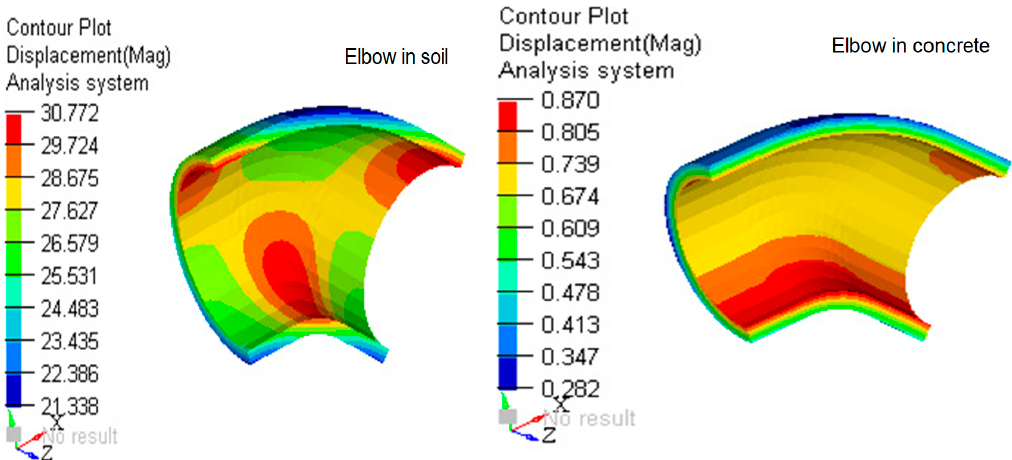
Figure 21. Displacements in section of elbow, in mm (load pressure 50 MPa).